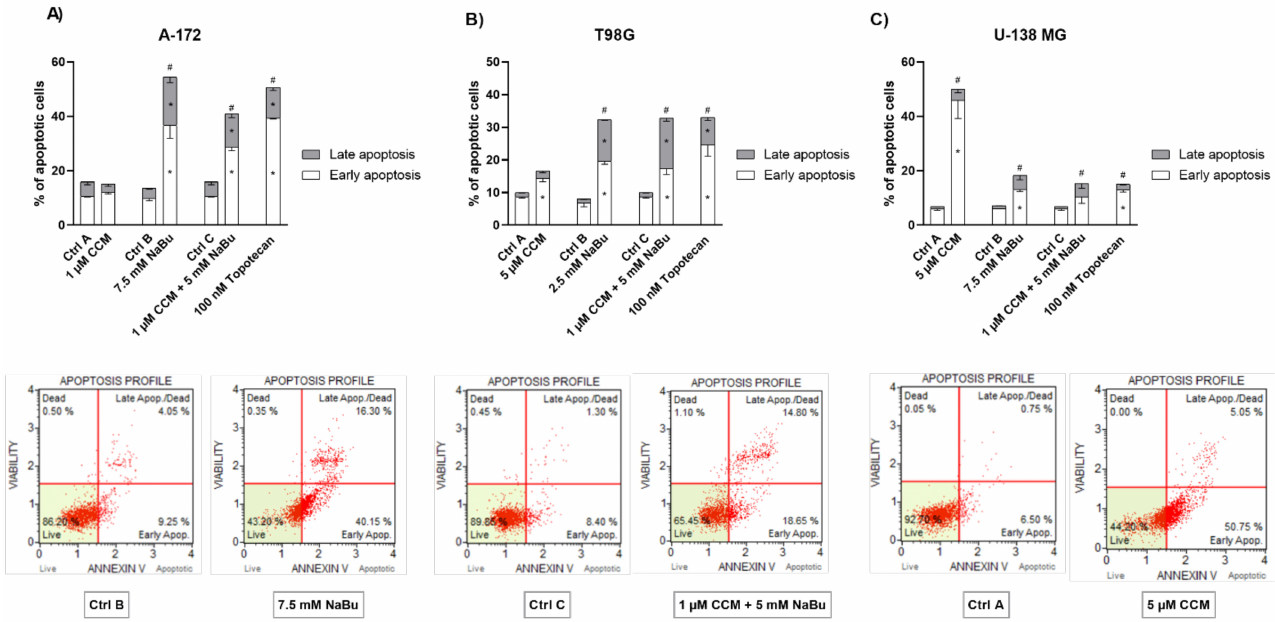
Figure 4. Effect of CCM and NaBu and their combinations on apoptosis detected in A-172 ( A ), T98G ( B ), and U-138 MG ( C ) cell lines after 48 h of treatment. Cells treated with vehicle (DMSO, PBS or both) are designated as Ctrl A, Ctrl B, and Ctrl C, respectively. In addition to each figure showing percentage of cells in early and late apoptosis phase, lower figures show histogram of compound/combination treatment with most significant proapoptotic effect compared to that of negative control (i.e., Ctrl B and 7.5 mM NaBu refer to A-172 cell line, Ctrl C and 1 µ M CCM and 5 mM NaBu refer to T98G cell line, and Ctrl A and 5 µ M CCM refer to U-138 MG cell line). Values are shown as mean ± SEM calculated from three independent experiments. (*) indicates statistically significant differences from control group for early/late apoptosis, (#) above bar indicates statistically significant differences from control group for total apoptotic cells, p <